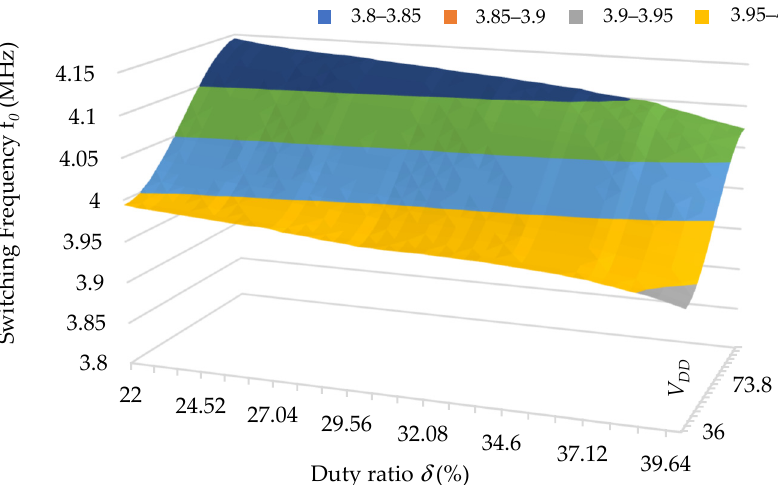
Figure 6. Desired switching frequency vs. duty ratio δ % and input voltage VDD.